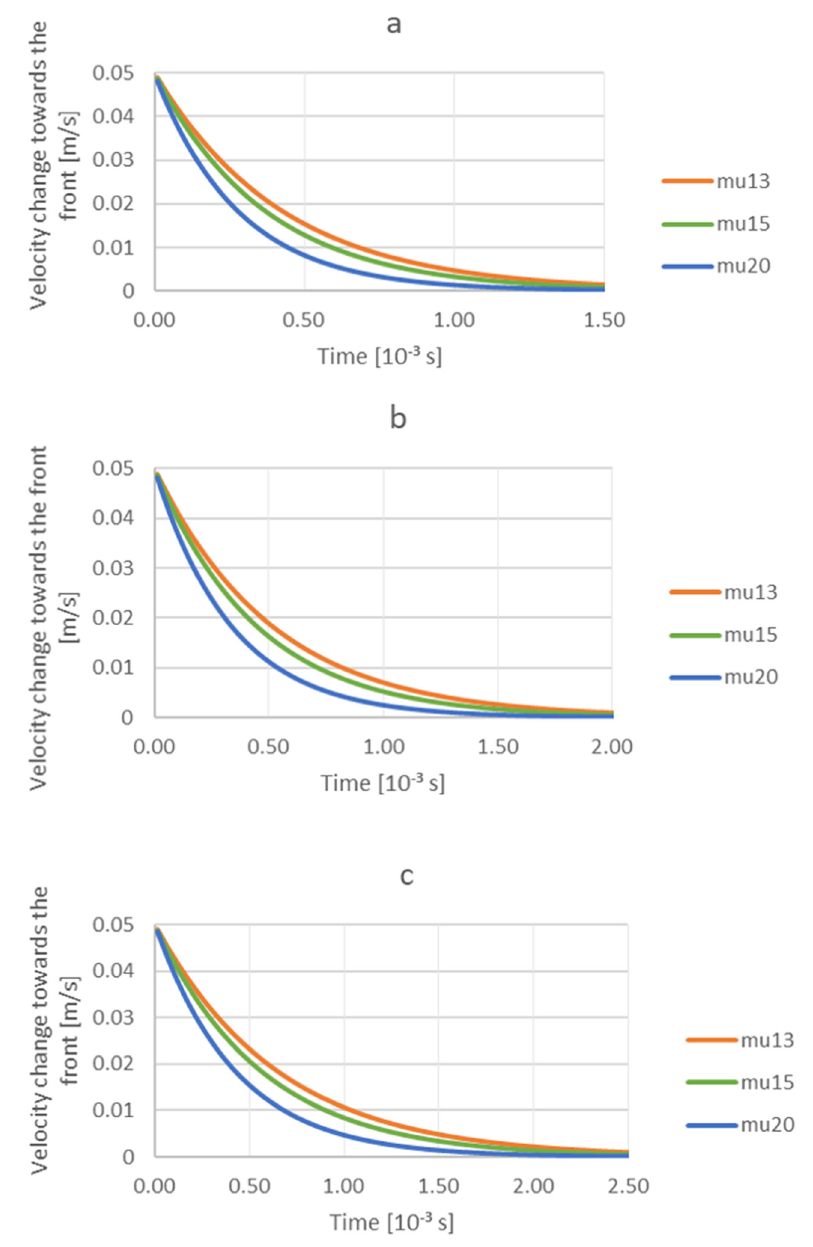
Figure 7. Analysis of the influence of TiC particle size and viscosity on the velocity change towards the front as a function of time with a constant gradient 0.00001 m/s. Radius of particle: ( a ) 6.40 × 10 − 8 m; ( b ) 7.75 × 10 − 8 m; ( c ) 9.85 × 10 − 8 m. Viscosity: mu13—0.0013 Pa·s; mu15—0.0015 Pa·s; mu20—0.0020 Pa·s.